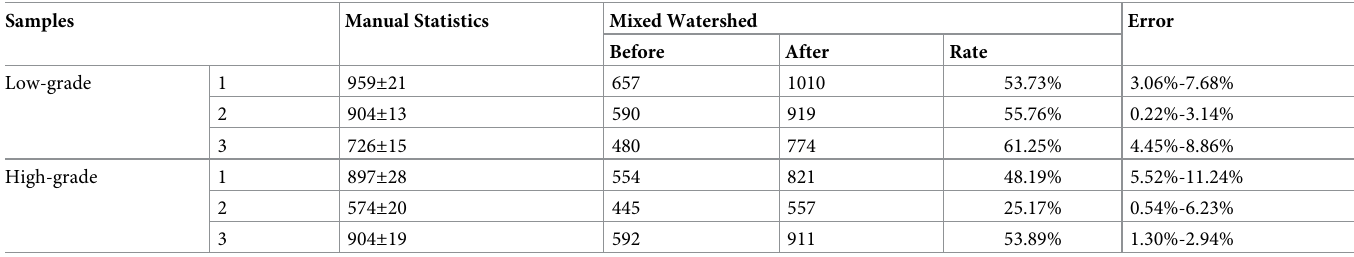
number of nuclei, and Before represents the statistical results before the adhesion nuclear seg- mentation, that is, the result of directly counting the number of nuclear foreground areas obtained by proposed method. After represents the statistical results after the Mixed Water- shed segmentation, Rate represents the rate of increase in the number of nuclei after adding the adhesion nuclear segmentation. Error gives an error range of the final statistics after water- shed segmentation compared with the manual statistics. The application of mixed watershed segmentation has a relatively strong impact on the number of nuclei, the lowest increase is greater than 25%, and most of the errors compared with the manual statistics are lower than 10%, which shows that the mixed watershed method